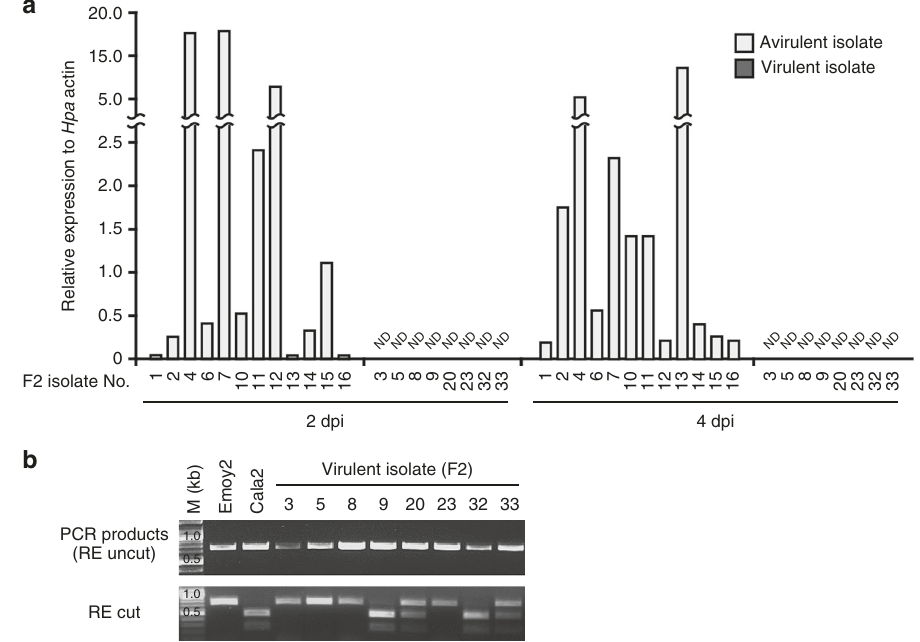
Fig. 6 In an Emoy2/Cala2 F2, virulence consists with lack of HaRxL103 expression. a Expression of HaRxL103 during infection in Emoy2/Cala2 F2 individual progeny which showed virulence or avirulence on CW84:RPP4 Col plants. Total RNA was prepared from the infections in Arabidopsis Ws-2 eds1-1 mutant at 2 or 4 dpi. qRT-PCR analysis was done as described in Fig. 1c. b Genotyping of the HaRxL103 locus in Emoy2/Cala2 F2 individual progeny which showed virulence on CW84:RPP4 Col plants. Genotyping of the HaRxL103 locus was performed by a CAPS (cleaved ampli fi ed polymorphic sequence) method. Upper and bottom panels indicate PCR products and those after restriction enzyme (RE) treatment, respectively. M marker, ND not